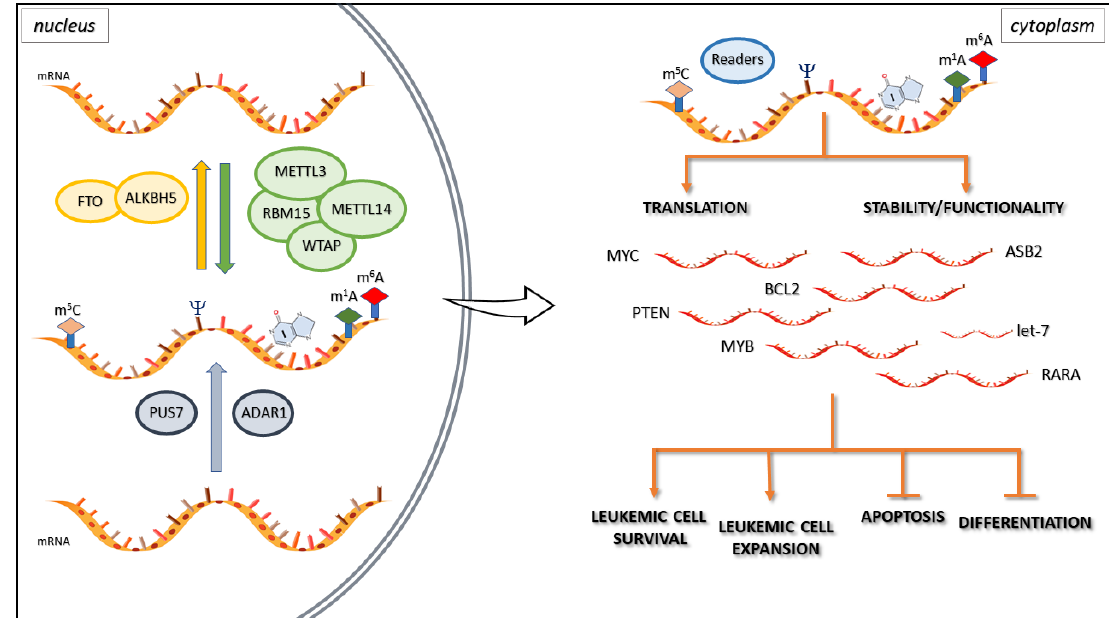
Figure 1. Schematic depiction of the principal components of epitranscriptomic mechanisms and their involvement in malignant hematopoiesis. Writers and erasers of main reversible methylations are represented in green and yellow, respectively. ADAR1 and PUS7 are the main enzymes involved in irreversible modifications (blue): ADAR1 converts adenosine to inosine, and PUS7 promotes pseudouridylation. Dysregulated modification affecting mRNA translation or RNA stability and/or more general functionality of some key RNA molecules promotes the leukemic phenotype.